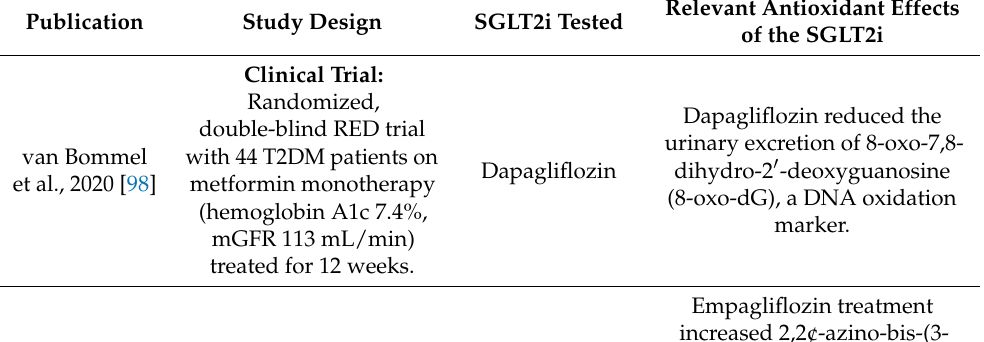
Table 2. Summary of the antioxidant effects of SGLT2is observed in clinical and preclinical